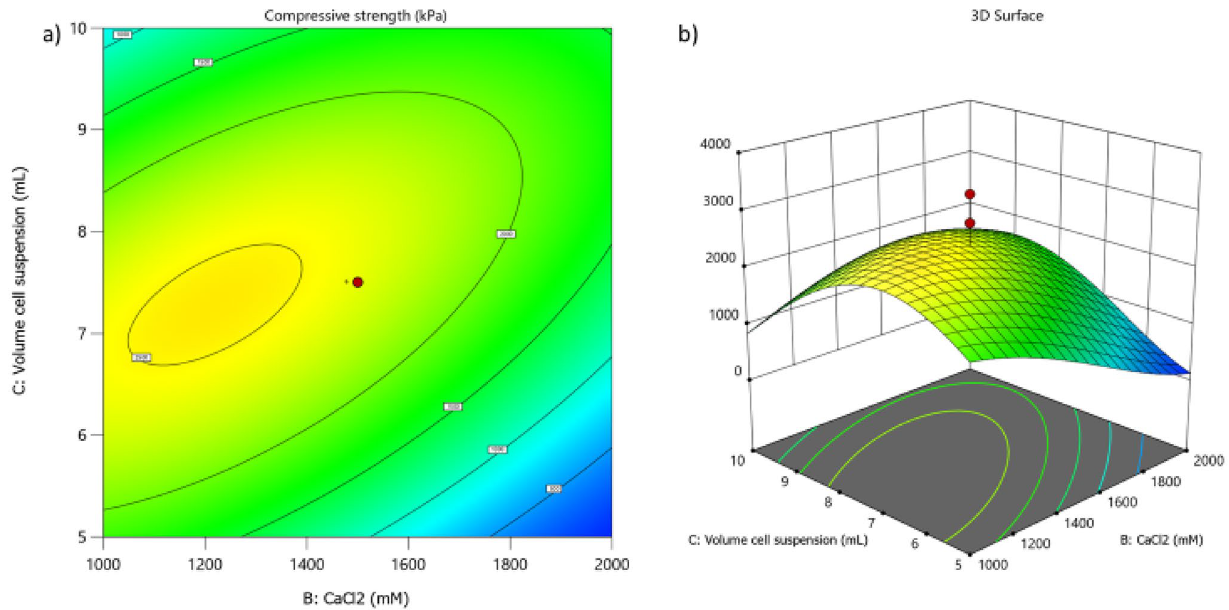
Fig. 3 a contour plot and b 3D-Surface plot of the interactive effects of calcium chloride concentration (B) and cell suspension (OD 1.6, 10.6 mM urea/min) (C) on the compressive strength of consolidated sand at constant urea concentration of 1500 mM